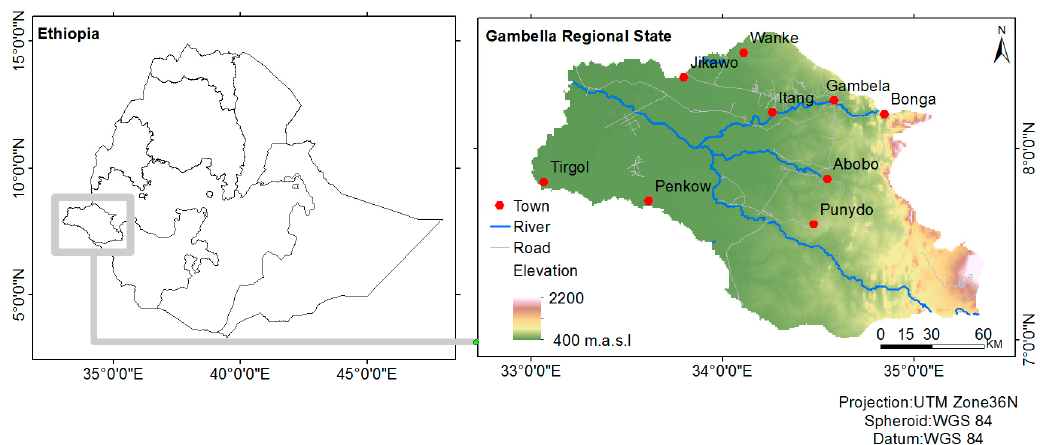
Figure 2. Gambella Locational Map: Federal Democratic Republic of Ethiopia (left) and Gambella Regional State (right).